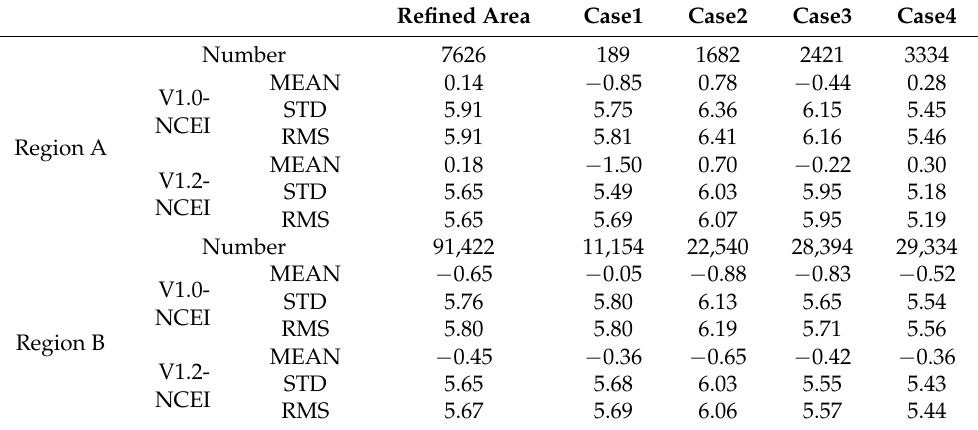
Table 9. Differences between SCSGAV1.2 and the testing shipborne data in different regions (in mGal). Refined Area Case1 Case2 Case3 Case4